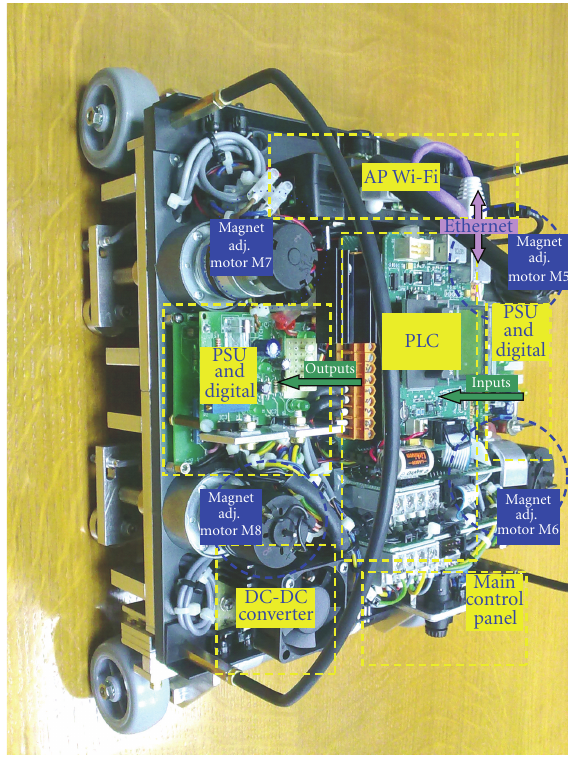
Figure 9: View from the top plane of the climbing